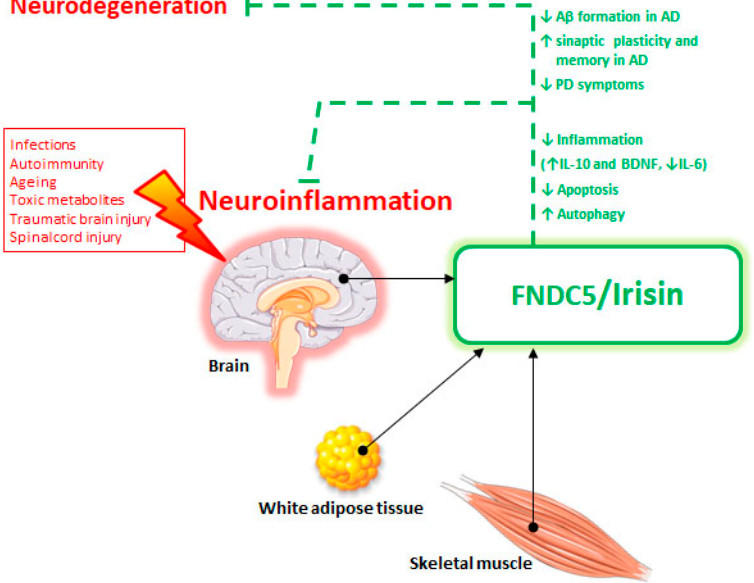
Figure 2. Scheme of fibronectin type III domain-containing protein 5 (FNDC5)/irisin system in the protection against neuroinflammation and neurodegeneration. Black arrows indicate irisin sources. Dotted green lines show the beneficial irisin effects. Green arrows indicate: ↑ increase and ↓ reduction .